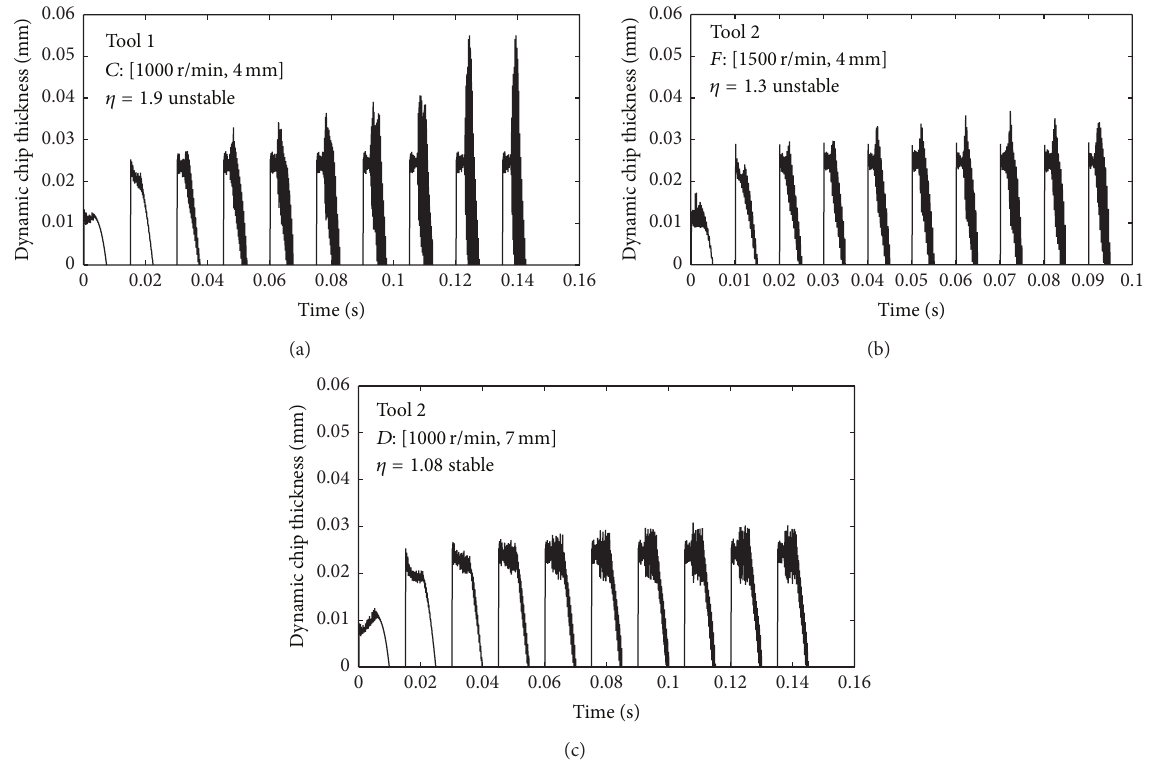
Figure 14: The dynamic chip thickness in different conditions.